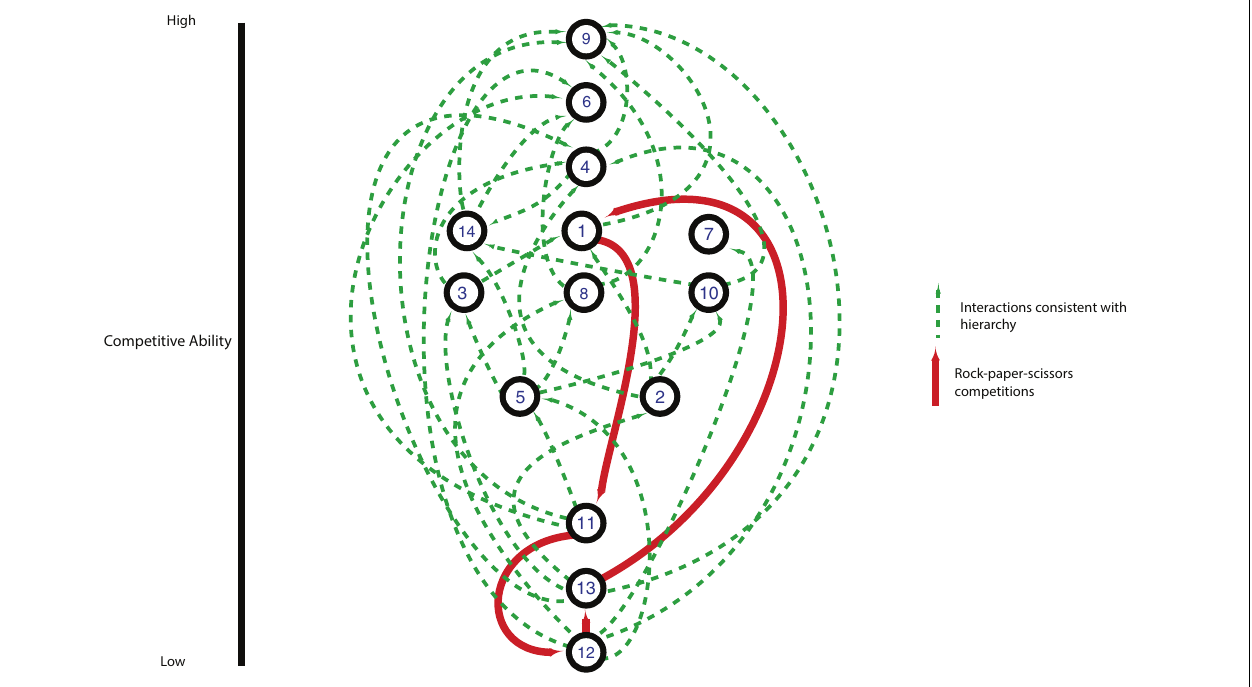
FIGURE 6 | Competitive network of an environmental Vibrio cholerae population. Numbered nodes indicate individual strains; edges indicate pairings with statistically significant competitive outcomes. Strains are ranked from most to least competitive on the y -axis based on a scoring system where a statistically significant competitive outcome is worth two points and a draw is worth one point. Arrows point toward winning strain in an individual competition, with green arrows indicating outcomes upward or level in the hierarchy and red arrows highlighting a lower strain winning against a higher-ranked